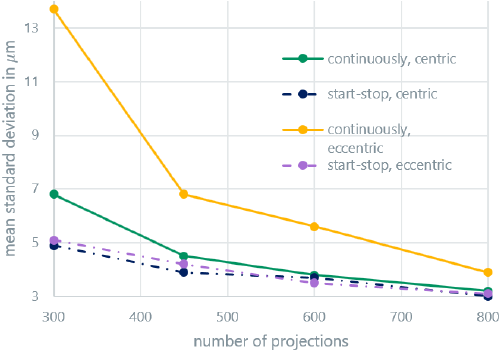
Figure 5. Systematic error in radius measurements.